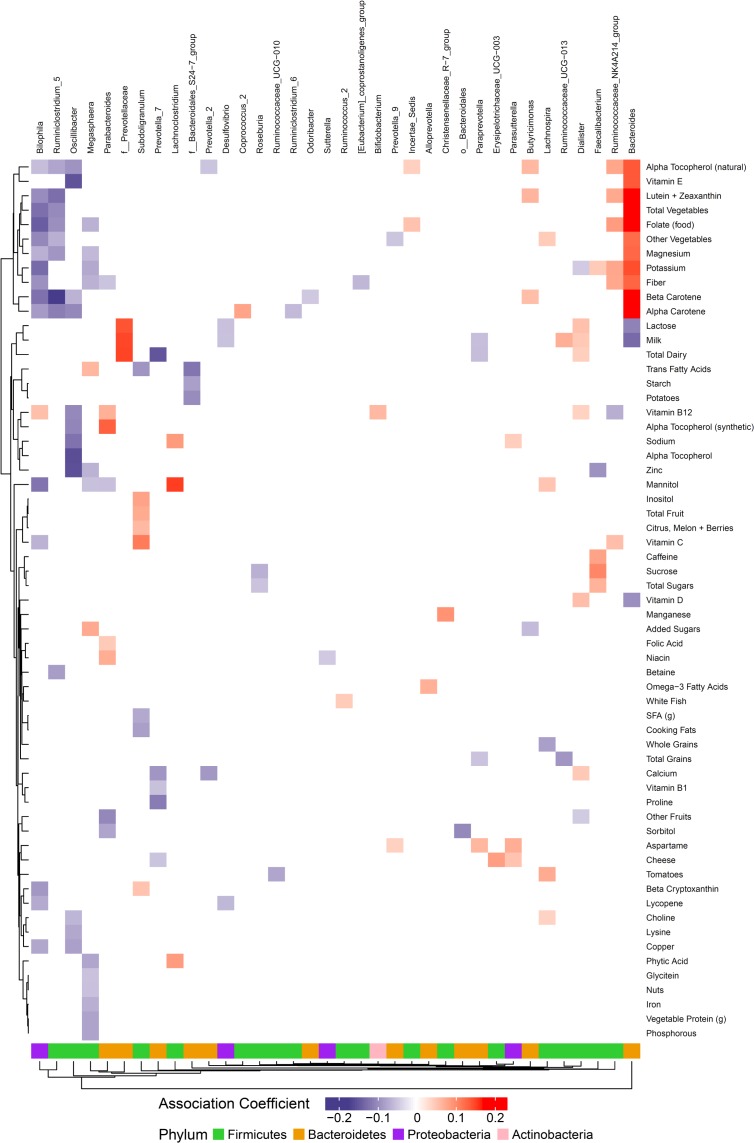
Associations between habitual dietary nutrient intake and gut microbiome. Color intensity reflects the magnitude of the association coefficients between dietary variables and taxa.